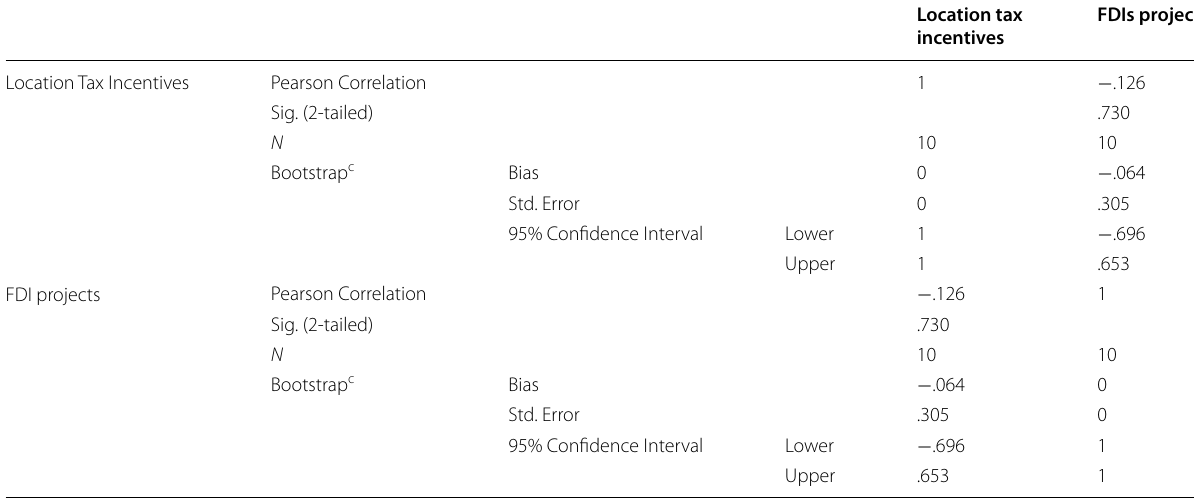
Table 12 The relationship between location tax incentives and FDI